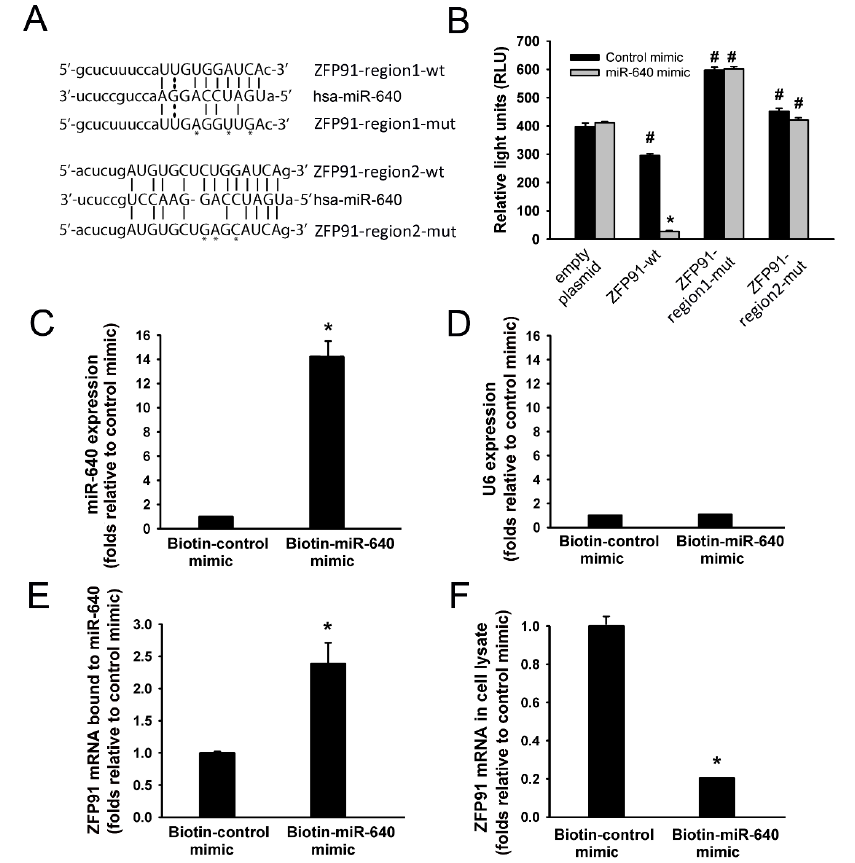
Figure 5. ZFP91 is a direct target of miR-640. ( A ): Sequence alignment of miR-640 and its target sites in 3 ′ UTRs of ZFP91. ( B ): Relative luciferase activity in HUVECs transfected with control or miR-640 mimics and luciferase reporter plasmid expressing wild type (wt) or mutated 3 ′ UTRs of ZFP91. The mutated 3 ′ UTRs of ZFP91 have mutated miR-649 binding regions 1 or 2. Values are means ± SEM, expressed as relative light units (RLU). * p < 0.05, compared to the control mimic. # p < 0.05, compared to empty plasmid. ( C and D ): Levels of miR-640 and U6 RNA measured 48 h after transfection of HUVECs with biotinylated control or mi-R-640 mimics. * p < 0.05, compared to the control mimic. ( E and F ): Levels of ZFP91 mRNA in the pulled down materials of biotinylated control and miR-640 mimics. Values are means ± SEM, expressed as folds relative to the control mimic. * p < 0.05, compared to the control mimic. ( F ): Levels of ZFP91 mRNA in the supernatant of cell lysates following pull downs of biotinylated control or miR-640 mimics. Values are means ± SEM, expressed as folds relative to the control mimic. * p < 0.05, compared to the control